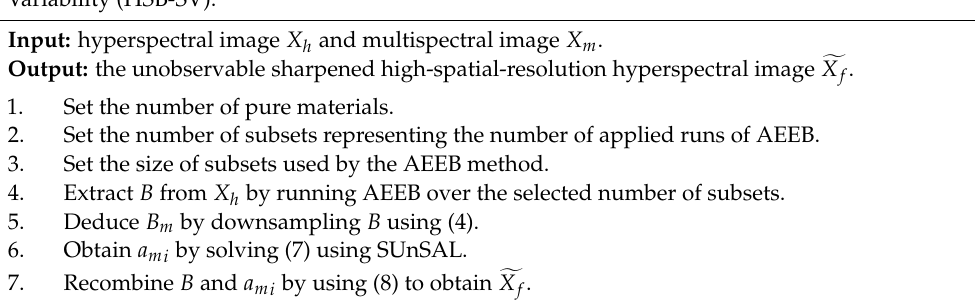
Algorithm 1. Hyperspectral Super-resolution with Spectra Bundles dealing with Spectral Variability